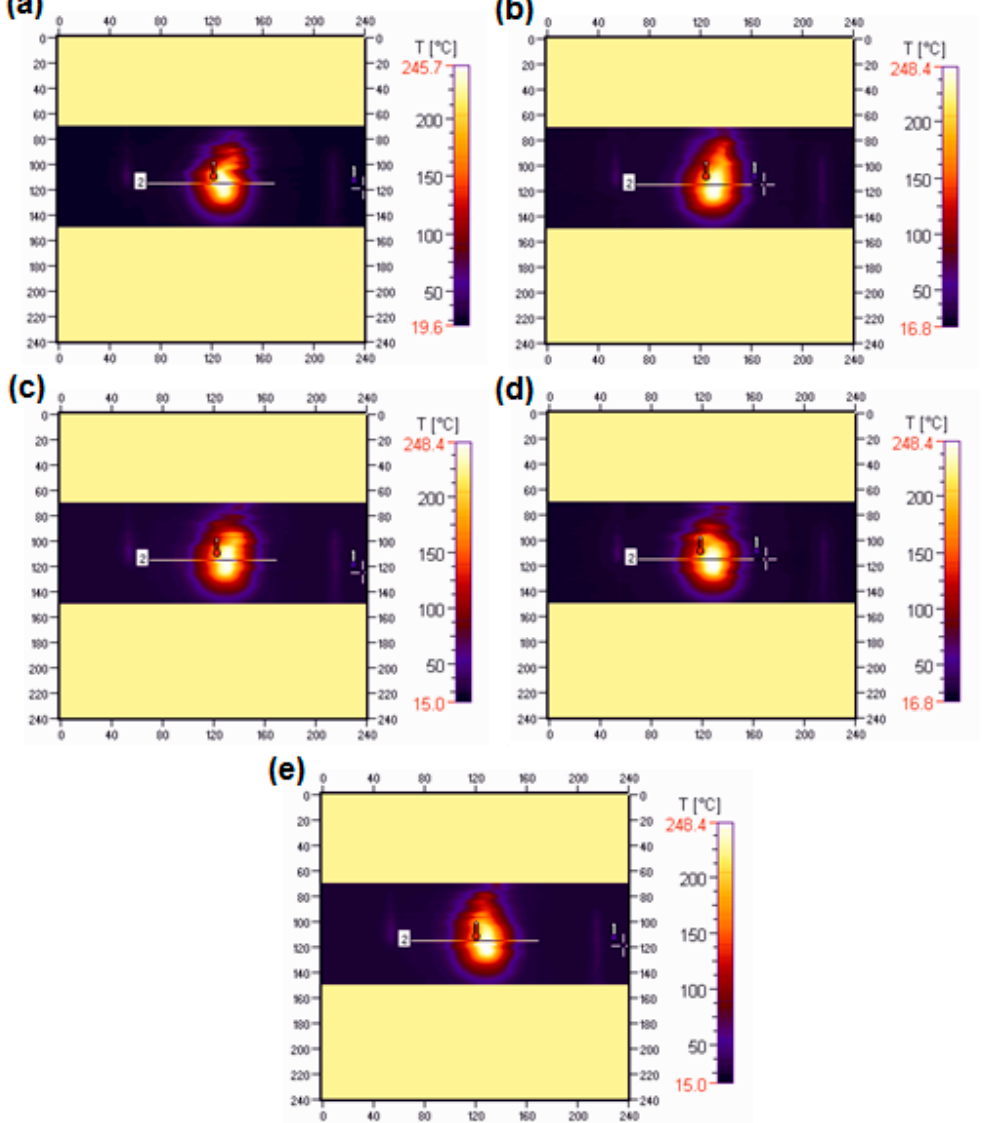
Figure 11. Thermograms of sample 1 (BPA.DM-NVP-0) recorded: 20 ( a ), 25 ( b ), 30 ( c ), 35 ( d ) and 40 ( e ) seconds after the ignition source application.